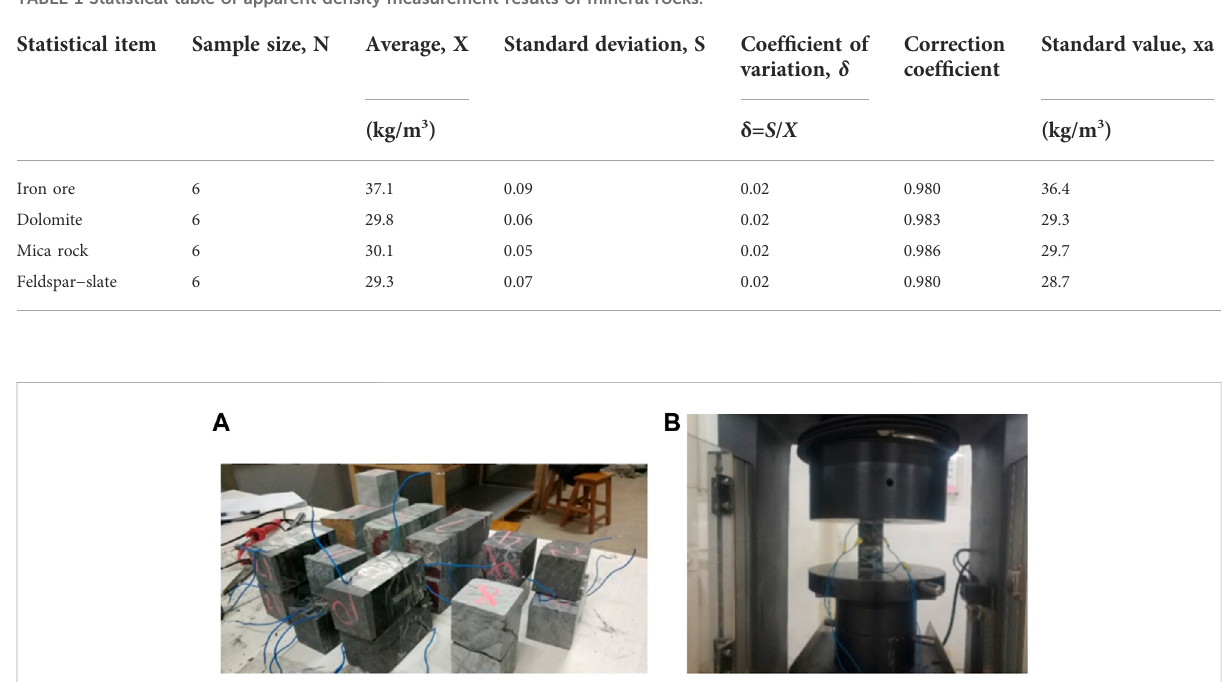
TABLE 1 Statistical table of apparent density measurement results of mineral rocks.